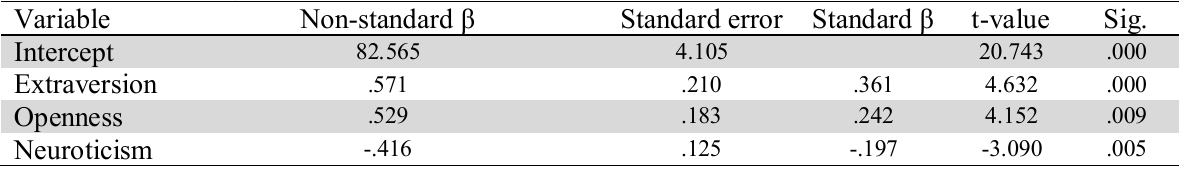
The summary of regression